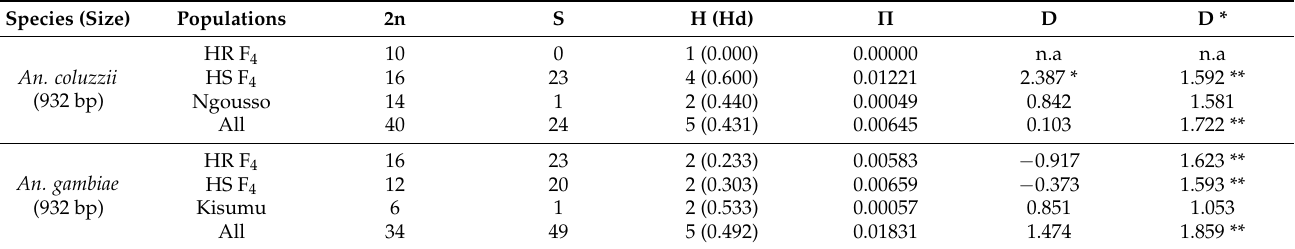
Table 1. Summary statistics for the polymorphism of CYP6M2 upstream region in permethrin highly susceptible and highly